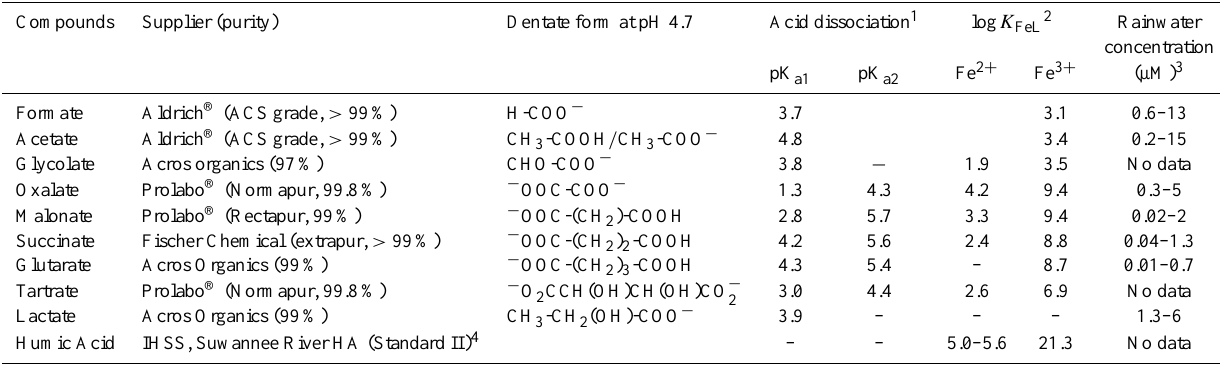
Table 1. Chemical characteristics of organic compounds and the range of concentrations measured in rainwater collected in various